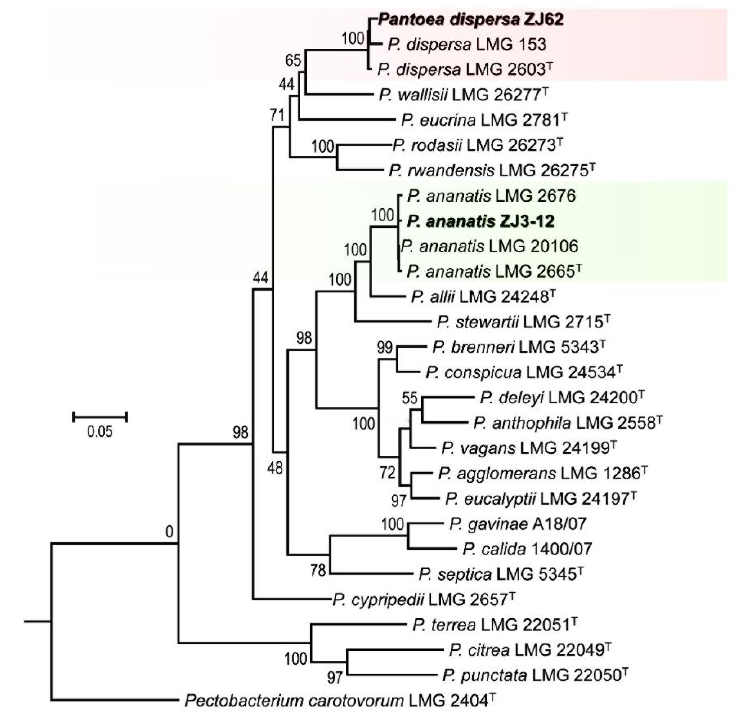
Figure 7. Maximum likelihood (ML) tree were constructed with RaxmlGUI v. 1.5 using the maximum likelihood method based on the concatenated sequences of gyrB , rpoB , atpD and infB of 28 Pantoea strains. The reference sequences of closely related species for Pantoea spp. were downloaded from GenBank database. Strains isolated from soil in this study are shown in bold. Bootstrap values after 1000 replicates are expressed as percentages. Pectobacterium carotovorum LMG 2404 T was used as an outgroup. Type strain was indicated with T.